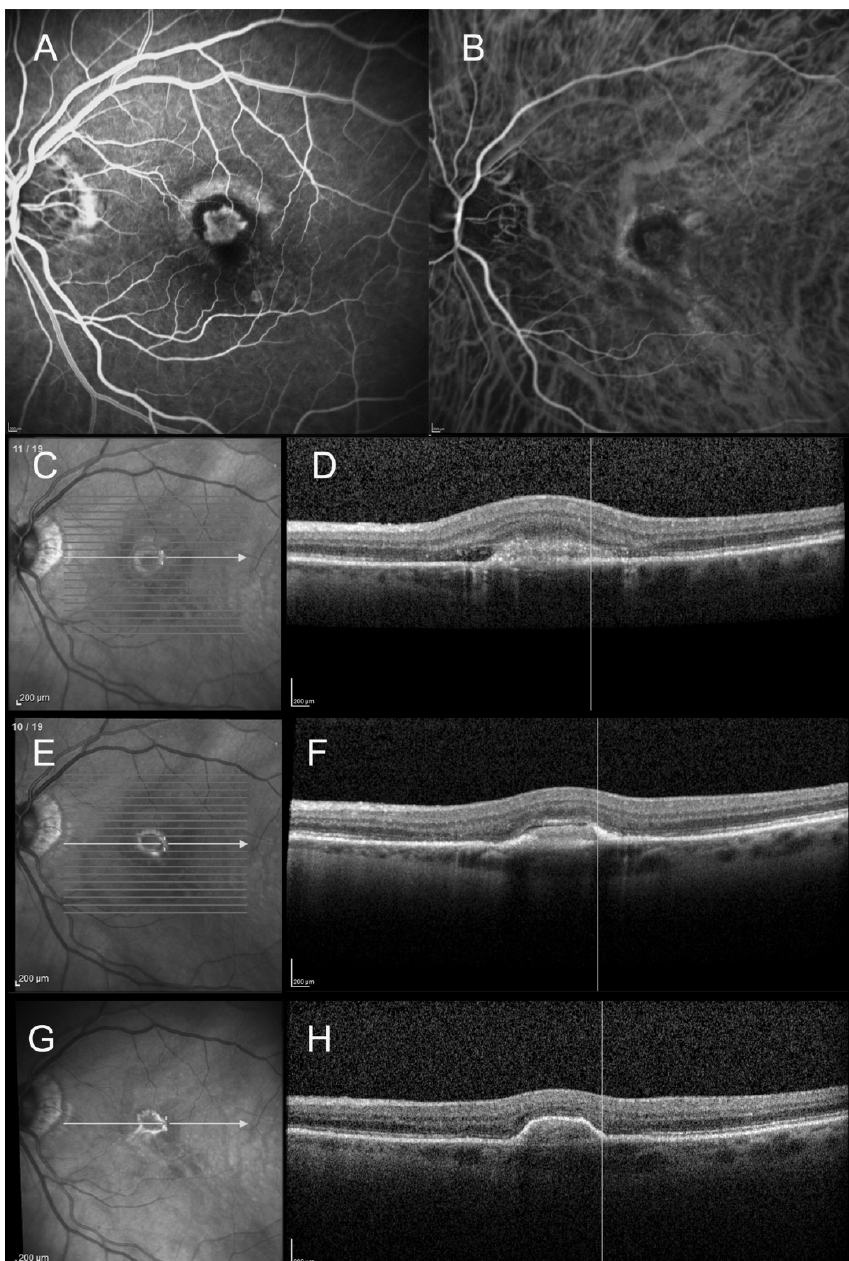
Figure 2. Spectral domain optical coherence tomography (SD-OCT) findings of an 83-year-old female patient with wet age-related macular degeneration (AMD) and initial type 2 macular neovascularization (MNV). The SD-OCT scans show the progression from type 2 MNV to fibrovascular PED and its margins (at baseline, 1 month after the first intravitreal anti-VEGF injection, and at 1-year follow-up). ( A ): Early-phase fluorescein angiogram (23 s) at baseline showing a well-demarcated early hyperfluorescence surrounded by a hypofluorescent rim. ( B ): Early-phase indocyanine green angiogram (21 s) at baseline showing the neovascular network surrounded by hypocyanescent margins. ( C ): Infrared reflectance photography at baseline, showing the initial hyperreflective ring. ( D ): Corresponding SD-OCT scan, showing the initial type 2 MNV, with subretinal fluid and hyperreflective exudation. The hyperreflective ring is within the limits of the neovascular lesion. ( E ): Infrared reflectance photography at 1 month after the first anti-VEGF injection, showing that the hyperreflective ring appeared well-demarcated and retractile. ( F ): Corresponding SD-OCT scan: the fibrovascular PED can be observed. ( G ): Infrared reflectance photography at 1-year follow-up: the hyperreflective ring is smaller and has a retractile aspect. ( H ): SD-OCT scan at 1-year follow-up: the hyperreflective ring corresponds to the limits of the fibrovascular PED lesion.